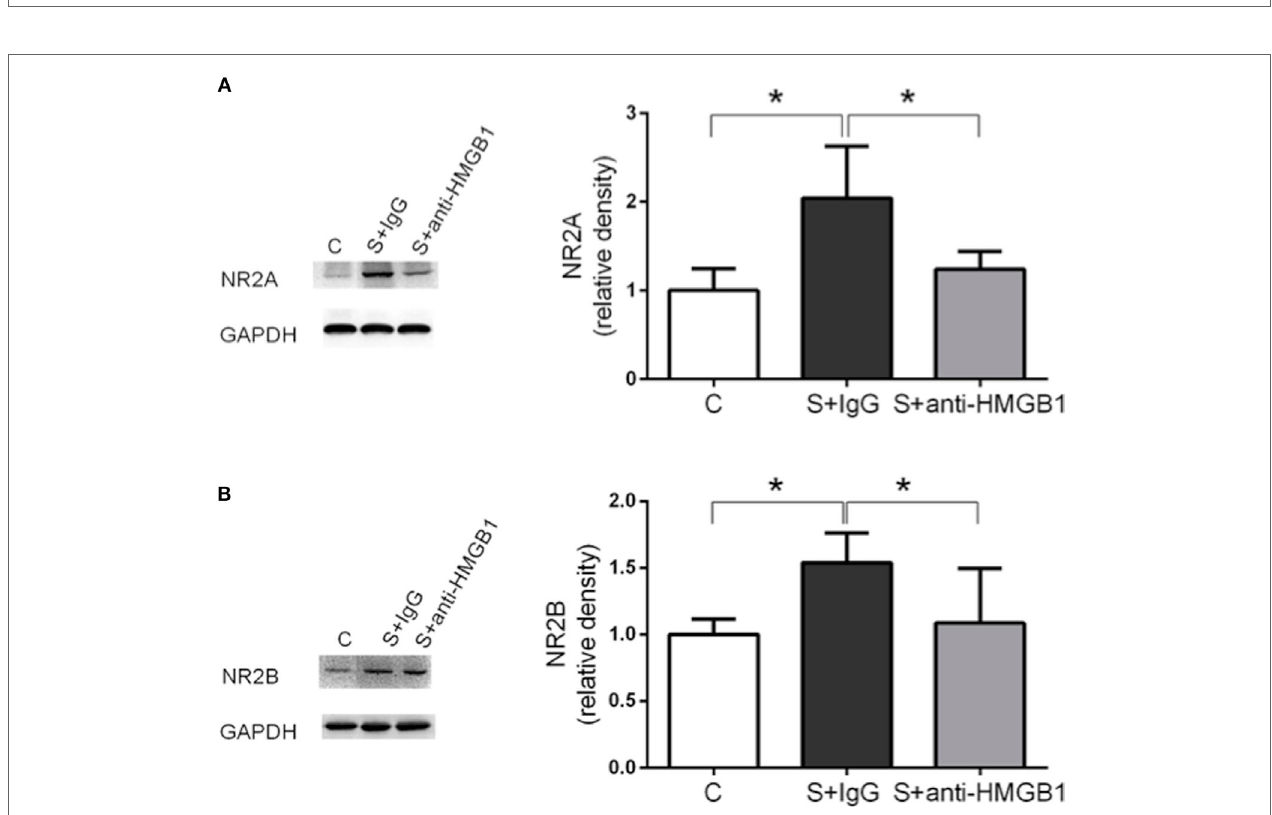
FigUre 3 | effects of anti-hMgB1 on nMDar subunits . Expression of NR2A (a) and NR2B (B) was assessed in the hippocampus on day 3. Immunoblots and quantifications are shown describing an increase in NR2A and NR2B levels after surgery that was restored almost to baseline by anti-HMGB1 mAb treatment. Results are expressed as mean ± SEM ( n = 5). * p < 0.05 by one-way ANOVA. Abbreviations: C, control; S, surgery. NR2A/B: N -methyl- d -aspartate receptor subunit